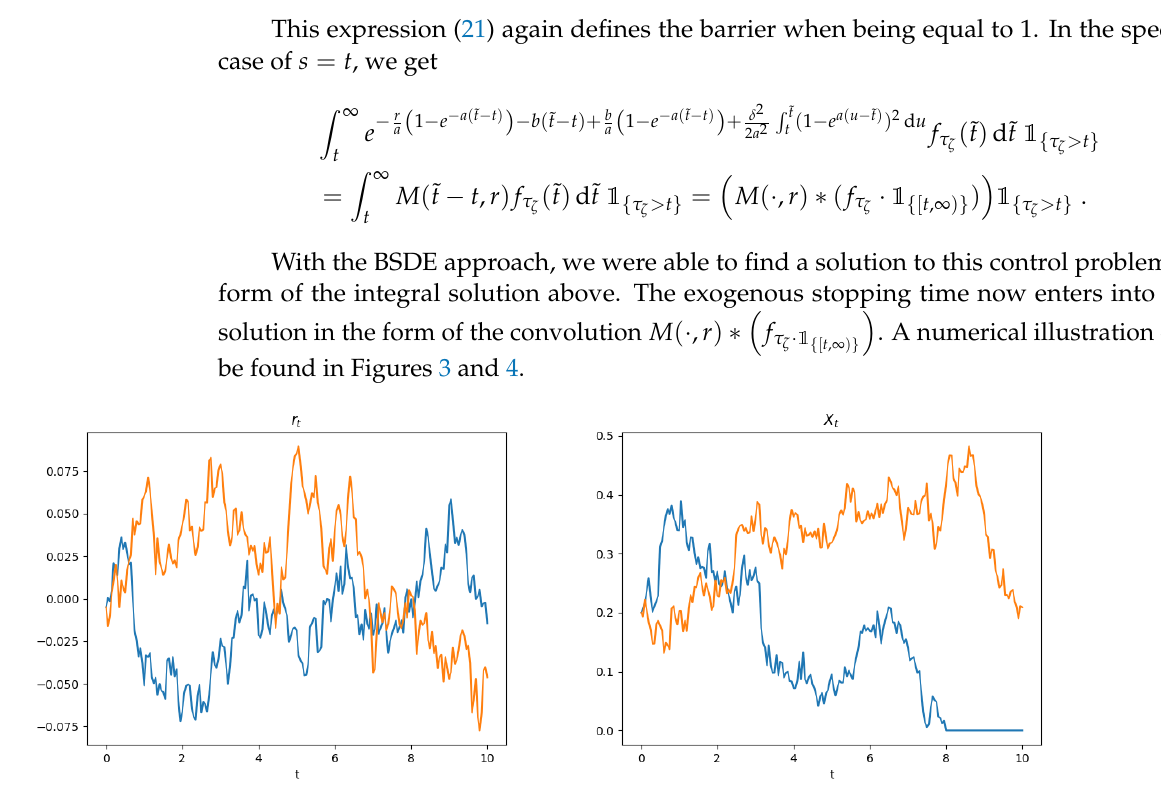
Figure 3. Interest rate ( left picture) and company wealth ( right picture), where the blue path hits the stopping boundary.